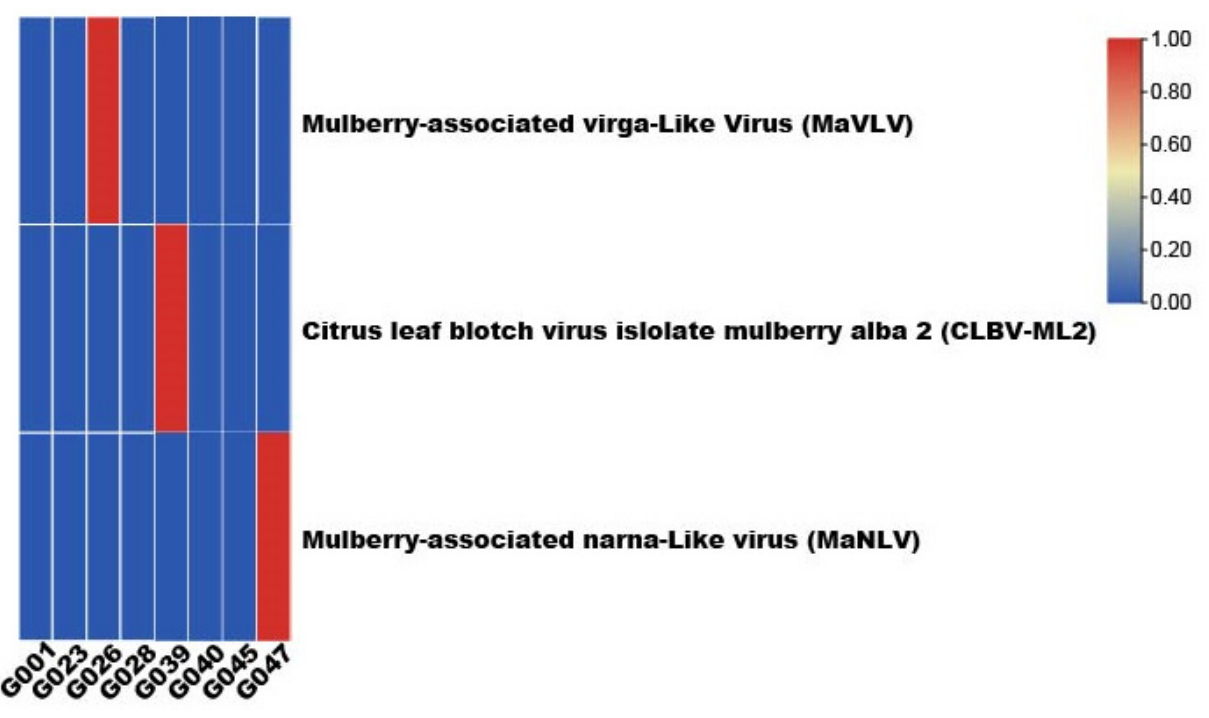
proteins. ORF3 and ORF4 are positioned at 9291-10061 nt and 10081-10614 nt in the ge-